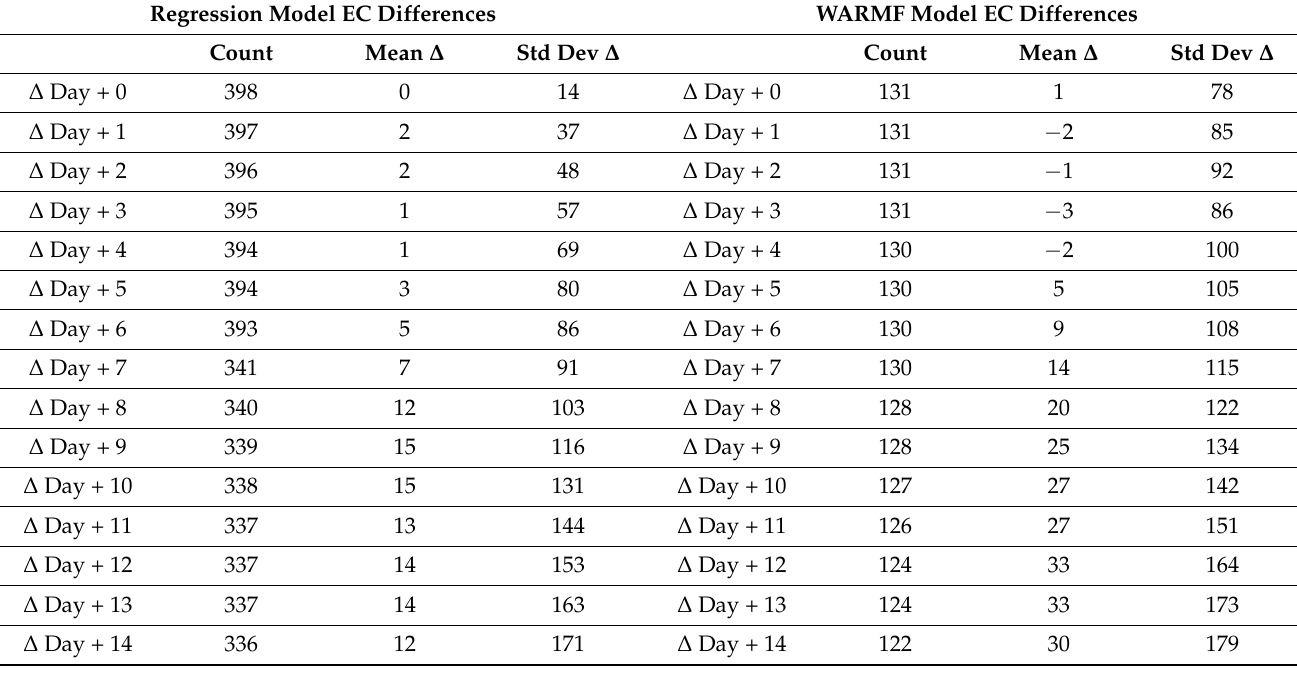
Table 3. Comparison of mean differences ( ∆ ) between forecasted EC and observed EC ( µ S/cm) for all model forecasts made between 22 February 2018 and 22 May 2020.